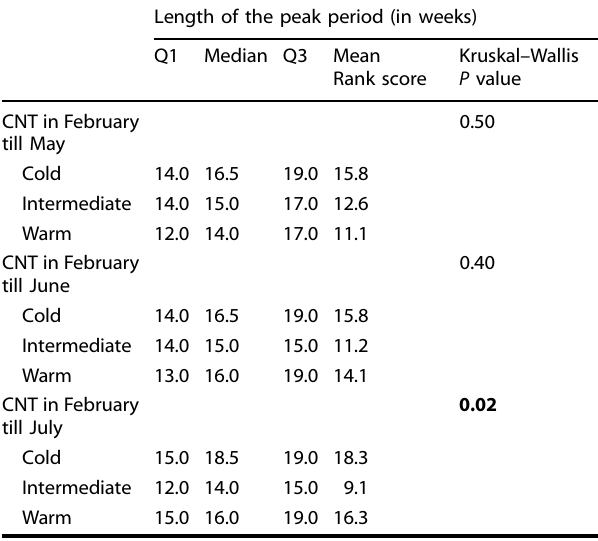
Table 3. Differences in length of the SAR peak period between relatively cold or warm periods of